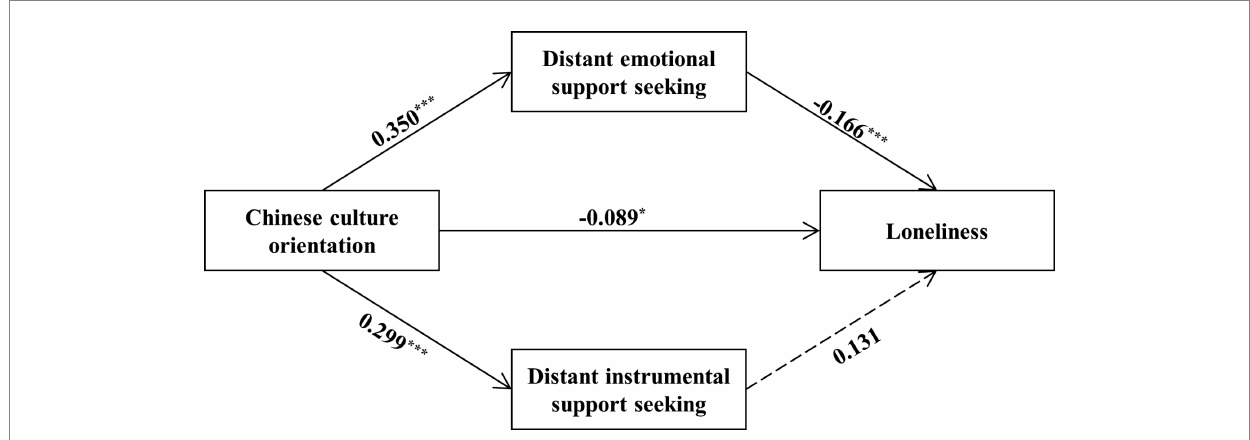
FIGURE 6 Mediation paths between Chinese-culture orientation and loneliness in the U.S. via distant support-seeking. Size of social network in the U.S. is included as a covariate in the model of